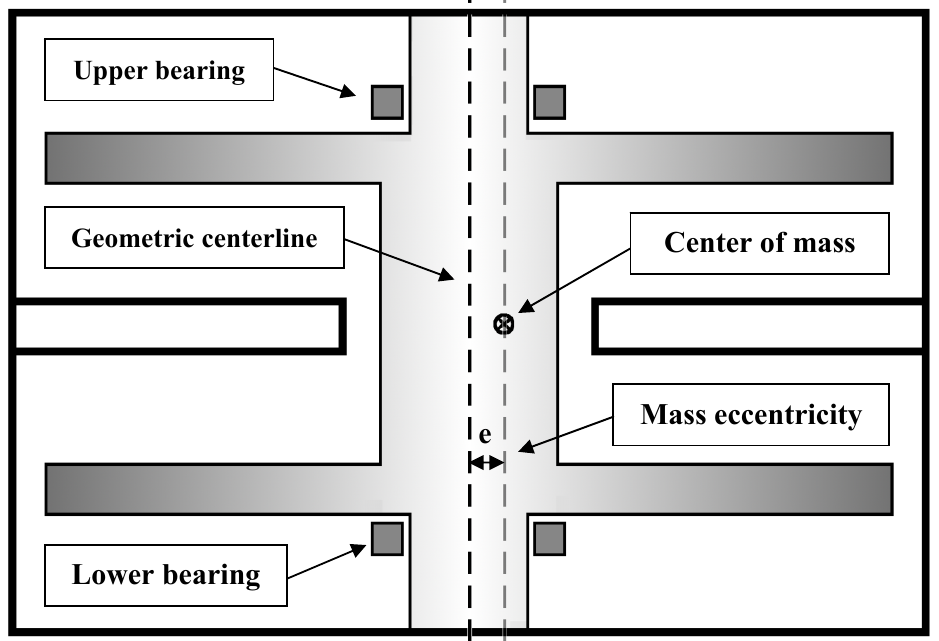
Figure 9. Geometry of the electric machine and position of the ball bearings.